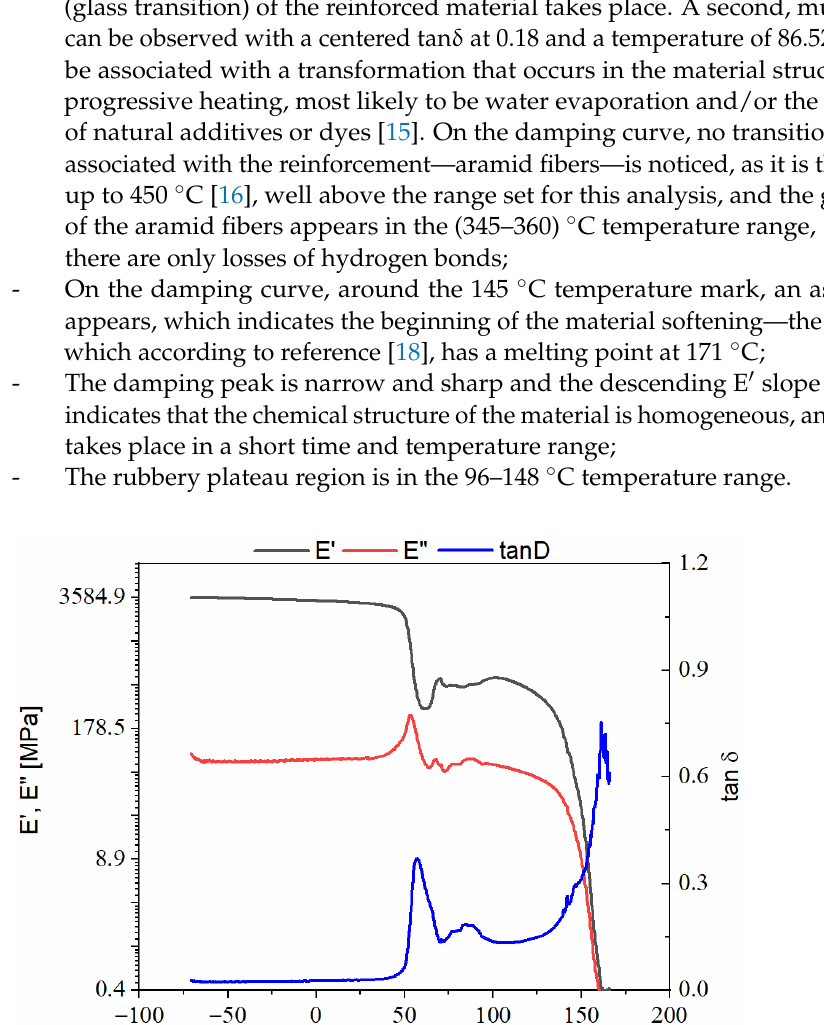
Arboform ® LV3 Nature reinforced with aramid fibers, Figure 4: